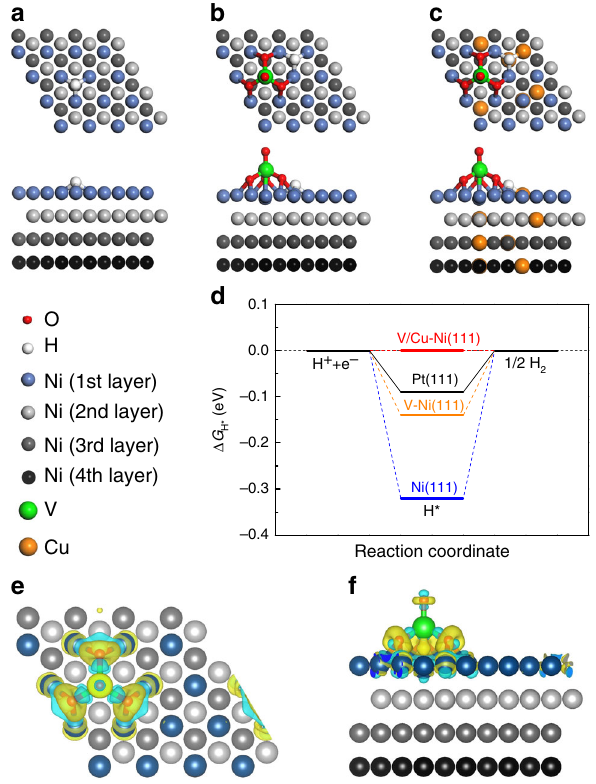
Fig. 4 Theoretical calculation of HER activation energy on the prepared catalysts. a The optimized structures of H * adsorbed on bare Ni(111), b V – Ni(111), and c V/Cu – Ni(111). d The calculated Δ G H* diagram of the HER at the equilibrium potential for various Ni(111) catalysts. The values for Pt (111) is also shown here for comparison. e , f The deformation electronic density of V – Ni(111). Yellow and cyan refer to electron-rich and electron- de fi cient area, respectively. The isosurface value is 0.005 e Å − 3